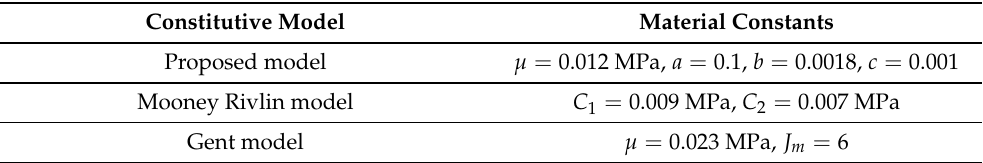
Table 3. Material parameters of proposed (19), Mooney Rivlin (20), and Gent (20) material models for